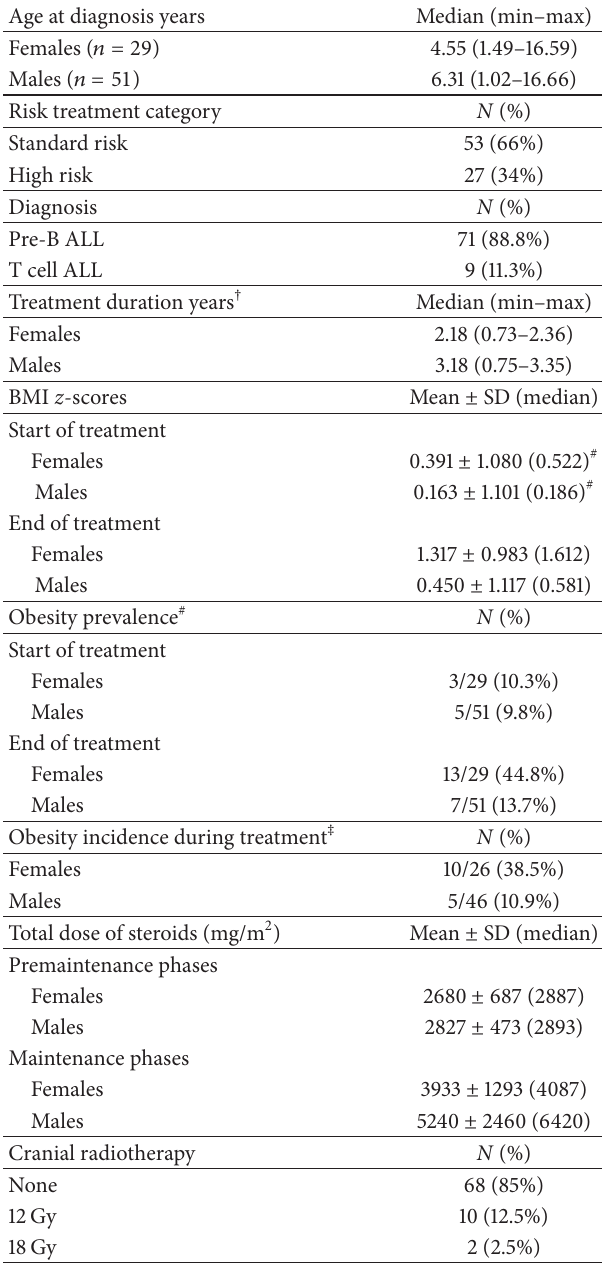
Table 1: Selected characteristics of the ALL study cohort ( 𝑁 = 80